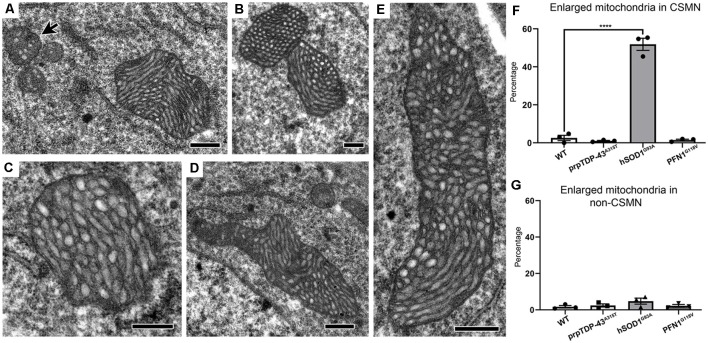
Mitochondria in CSMN of hSOD1G93A mice are extensively enlarged at P15. (A–E) Representative images of enlarged mitochondria in CSMN of hSOD1G93A mice. Arrow marks examples of normal size mitochondria. (F) Quantification of percentage of CSMN that contain enlarged mitochondria in WT, prpTDP-43A315T, hSOD1G93A and PFN1G118V mice. (G) Quantification of percentage of non-CSMN cells that contain enlarged mitochondria in WT, prpTDP-43A315T, hSOD1G93A and PFN1G118V mice. p-value **** <0.0001. Scale bar: (A–E) = 500 nm.